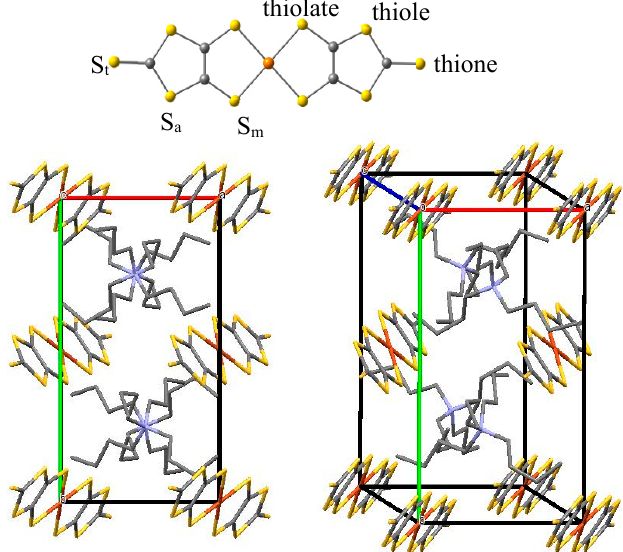
Figure 1. ( top ) Molecular structure of the planar [Cu(dmit) 2 ] − 2 complex, with the notation employed for the S atoms. ( bottom ) View of the [n-Bu 4 N] 2 [Cu(dmit) 2 ] crystal along b axis ( left ) and 3D view of the crystal ( right ), where the H atoms have been omitted. Yellow, orange, gray, and blue wires (balls) correspond to S, Cu, C, and N atoms, respectively.